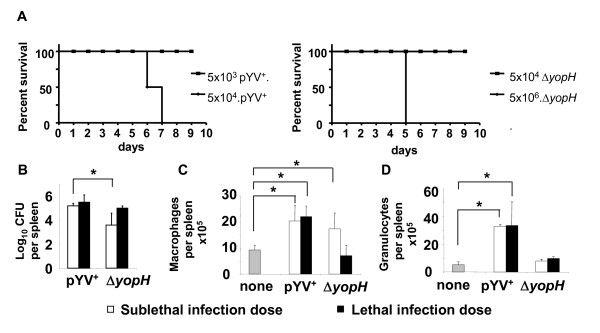
Infection of mice with pYV+ and ΔyopH. (A) Survival curve of C57BL/6 mice upon i.v. infection with 5 × 103 or 5 × 104 pYV+, or with 5 × 104 or 5 × 106 ΔyopH (B) The bacterial numbers in the spleen of mice and total number of (C) macrophages and (D) granulocytes in the spleen was determined 24 h after infection. The data were from two independent the means ± standard deviation of at least ten mice per group. Asterisks indicate significant differences (p < 0.05, A and B, logrank test; C, Wilcoxon rank test, D and E, One-Way ANOVA with Dunnett test) between the compared groups.